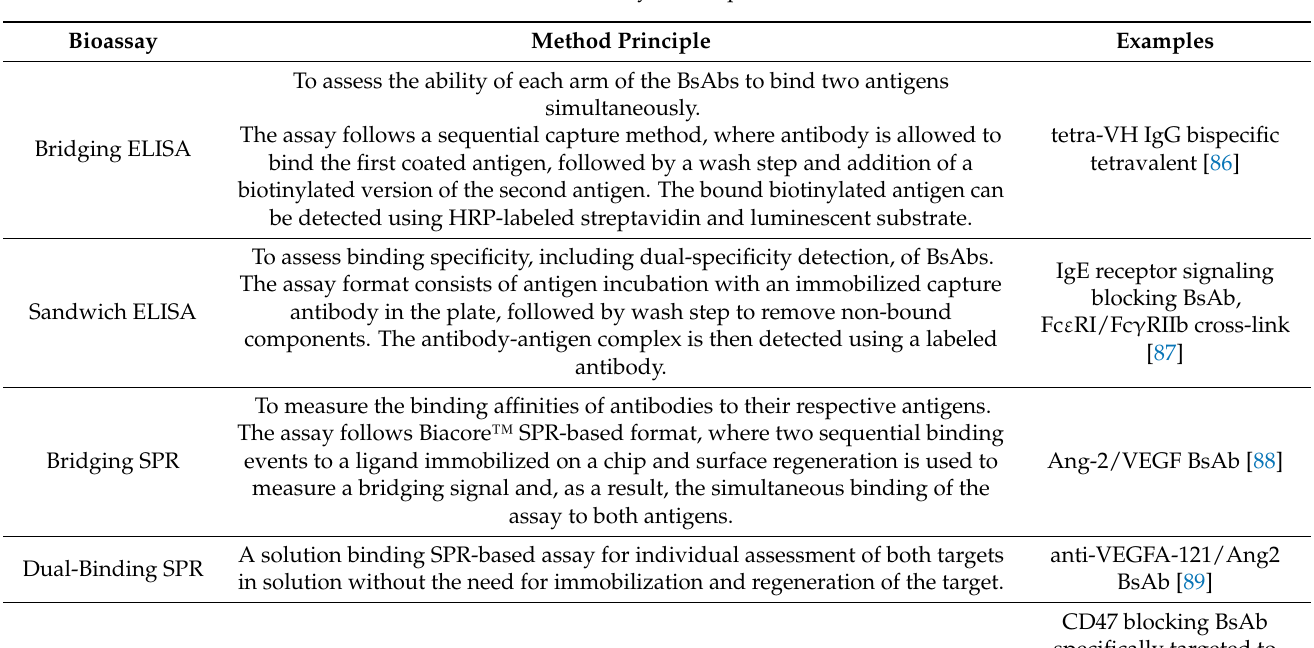
Table 1. List of bioassays for bispecific molecules.